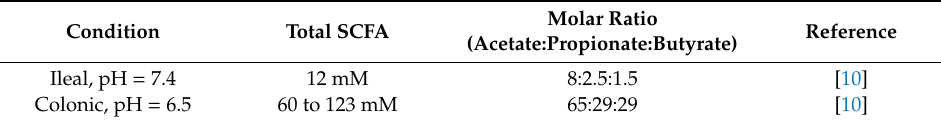
Table 1. Experimental conditions.